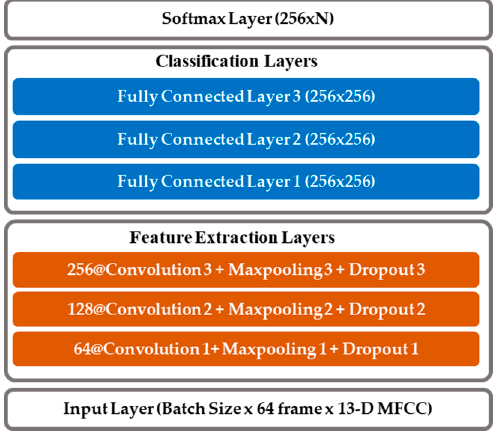
Figure A7. Layer configuration for CNN-based trigger word detection.